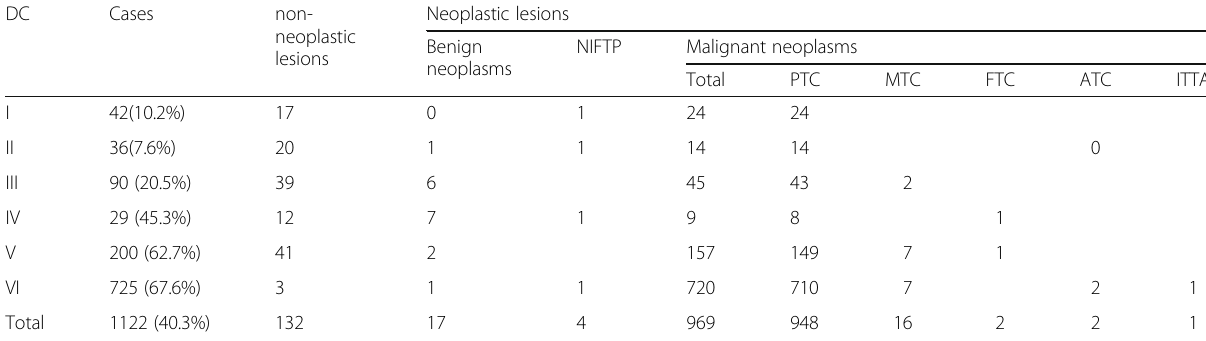
Table 1 The distribution of the cytologic-histologic correlation of the nodules DC Cases non-